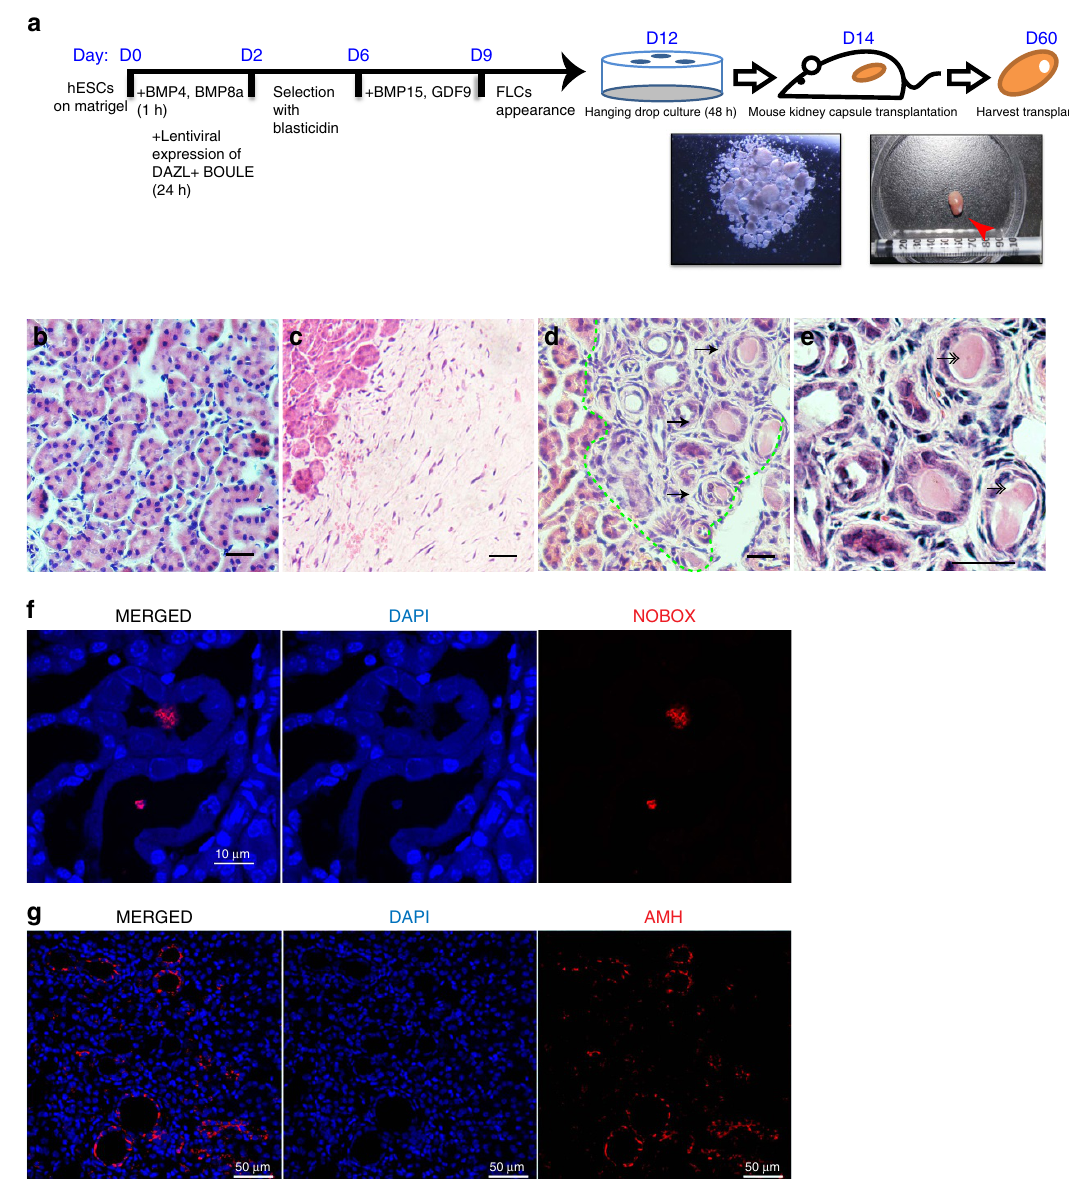
Figure 7 | Existence of ovarian FLCs after transplantation into mouse kidney capsules. ( a ) Schematic timelines and simplified protocols for the differentiation of the undifferentiated hESCs to the harvesting of the transplant from mouse kidney capsules. Red arrow: harvested transplant. Representative images of H&E staining of a kidney area next to the transplant ( b ), a control transplant containing differentiated hESCs without inducers ( c ), a transplant containing suspended FLCs as described in ( d ), and a magnified picture of FLCs in the transplant ( e ). Arrows: FLCs with primary follicle-like structures; double-headed-arrows: GV-like staining in the FLCs. ( f ) Immunofluorescent staining of NOBOX in the transplant showing colocalisation of NOBOX and nuclei in the middle of follicles. ( g ) Immunofluorescent staining of AMH in the transplant showing the AMH-positive cells localized to the surrounding cells of follicles. Bar, 50 m m in b – e , g ; 10 m m in f . Three independent transplantation experiments were and BMP8a (R&D systems)) for 1h at 37 (cid:2) C with 5% CO 2. This procedure was followed by transduction with lentiviral supernatant expressing DAZL and BOULE for 1 day, recovery for 1 day, selection for 3 days with blasticidin at 2 m gml (cid:2) 1 , and recovery for another day. At day 7, the differentiated hESCs were incubated with differentiation medium containing 0.35ngml (cid:2) 1 GDF9:BMP15 heterodimer (prepared as described previously in Matzuk’s lab 39 ) and 10ngml (cid:2) 1 EGF (R&D) for 1 day, followed by new differentiation medium containing 50ngml (cid:2) 1 GDF9 and 25ngml (cid:2) 1 BMP15 (R&D systems). Thereafter, the differentiation medium containing 50ngml (cid:2) 1 GDF9 and 25ngml (cid:2) 1 BMP15 was replaced every 3 days until FLCs appeared or the cells were harvested. Human fetal ovary tissues . Human fetal ovaries were procured from Tsinghua University Second Hospital with the approval of the institutional review boards (IRB) of the hospital and the IRB of the School of Medicine, Tsinghua University.